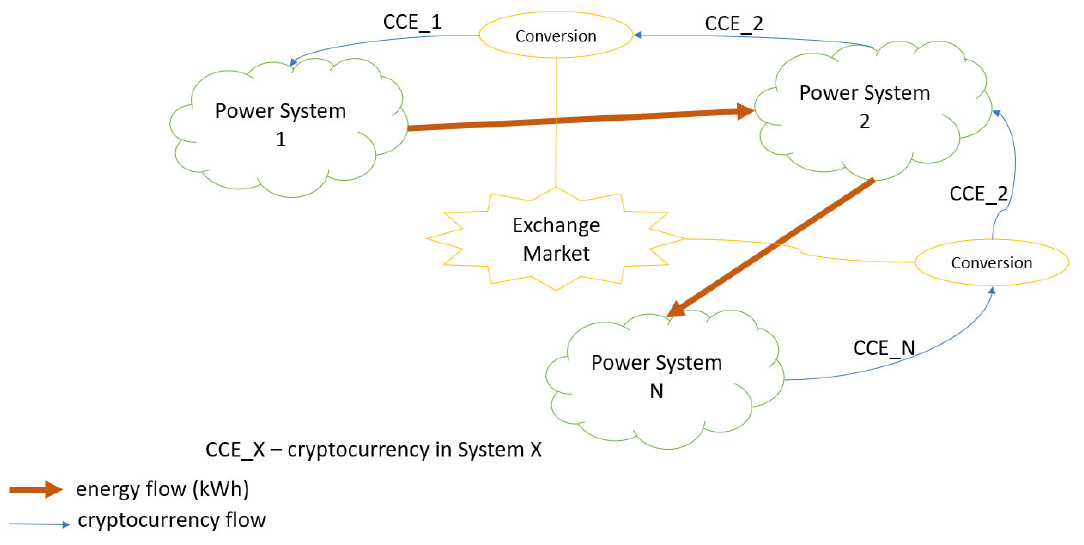
Figure 2. The ability to convert cryptocurrencies between energy exchange systems.